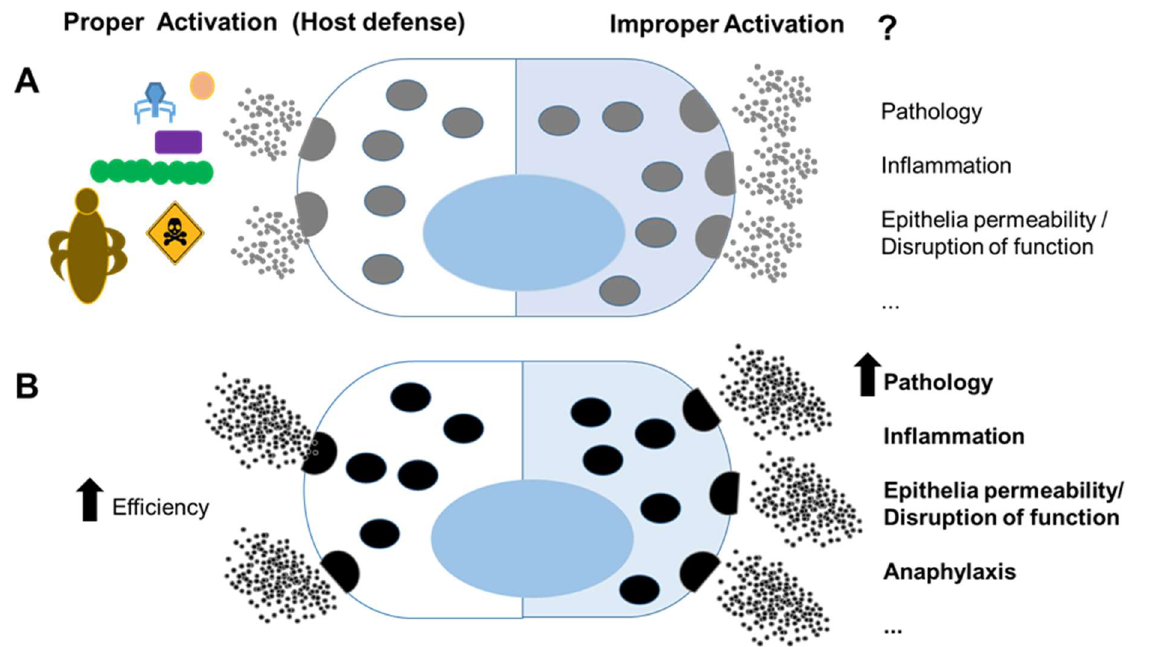
Figure 1. Mast cells in host defense and pathology: ( A ) mast cells have recognized roles in immunity against pathogens and venoms ( left ); however, improper activation against innocuous agents or dysregulated activation may lead to pathology ( right ); ( B ) mast cells that host genetic factors and mutations, possibly promoted by benefits of survival, more efficiently clear pathogen and venoms ( left ); however, they can lead to a more severe pathology under inappropriate activation ( right ). Funding: This study was funded by a grant from the Spanish Ministry of Science, Innovation and Universities and European Regional Development Fund/European Social Fund “Investing in your future”: RTI2018-096915-B100.